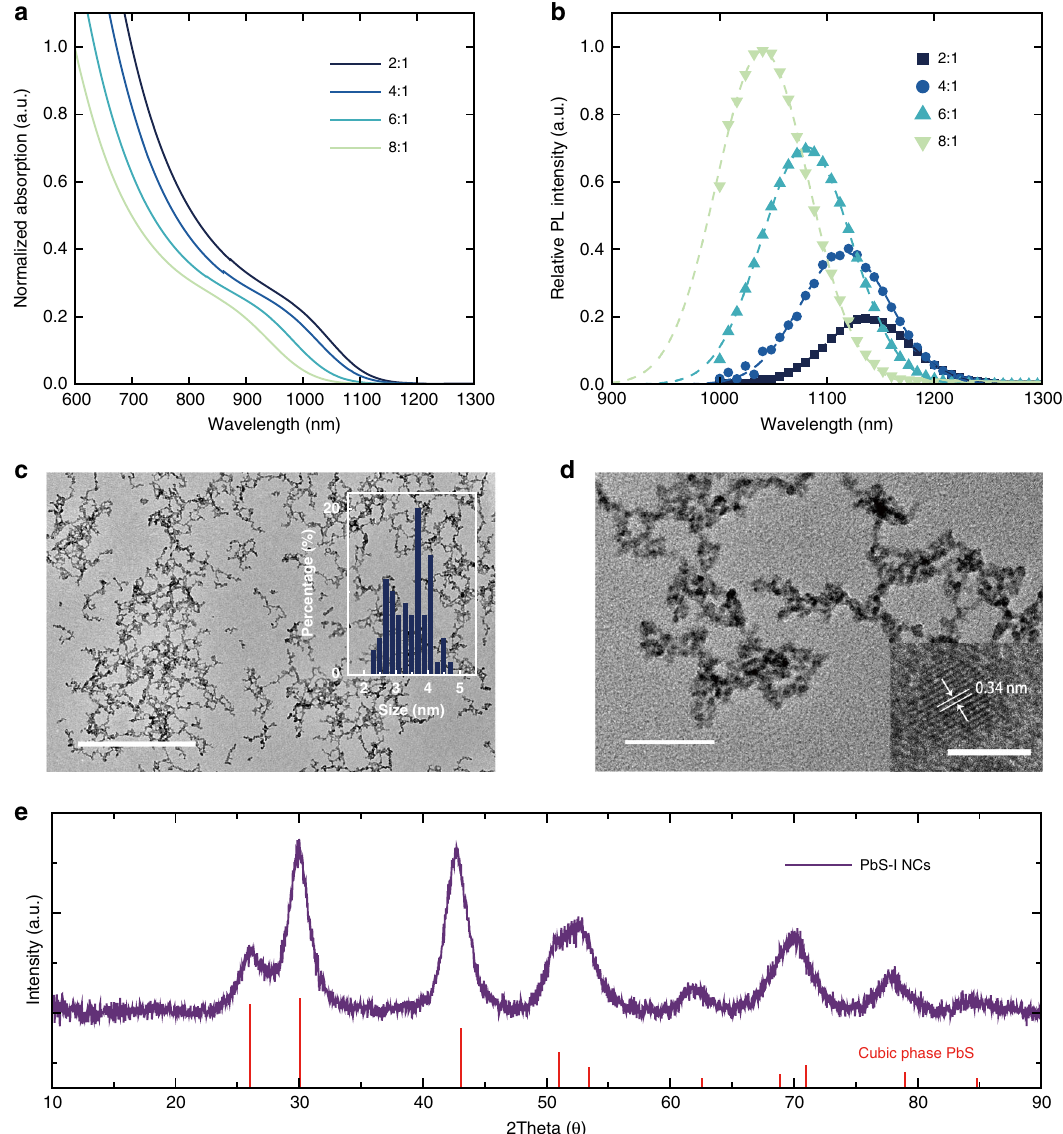
Fig. 2 Characterization of direct-synthesized PbS-I NCs inks. Absorption ( a ) and PL spectrum ( b ) of synthesized PbS-I NCs with different Pb/S Precursor ratio. Transmission Electron Microscopy (TEM) images ( c , d ) and X-ray diffraction (XRD) pattern ( e ) of PbS-I NCs, indicating a cubic phase PbS crystal lattice. (Scale bar: 500 nm in ( c ), 50 nm in ( d ) and 5 nm in ( d )